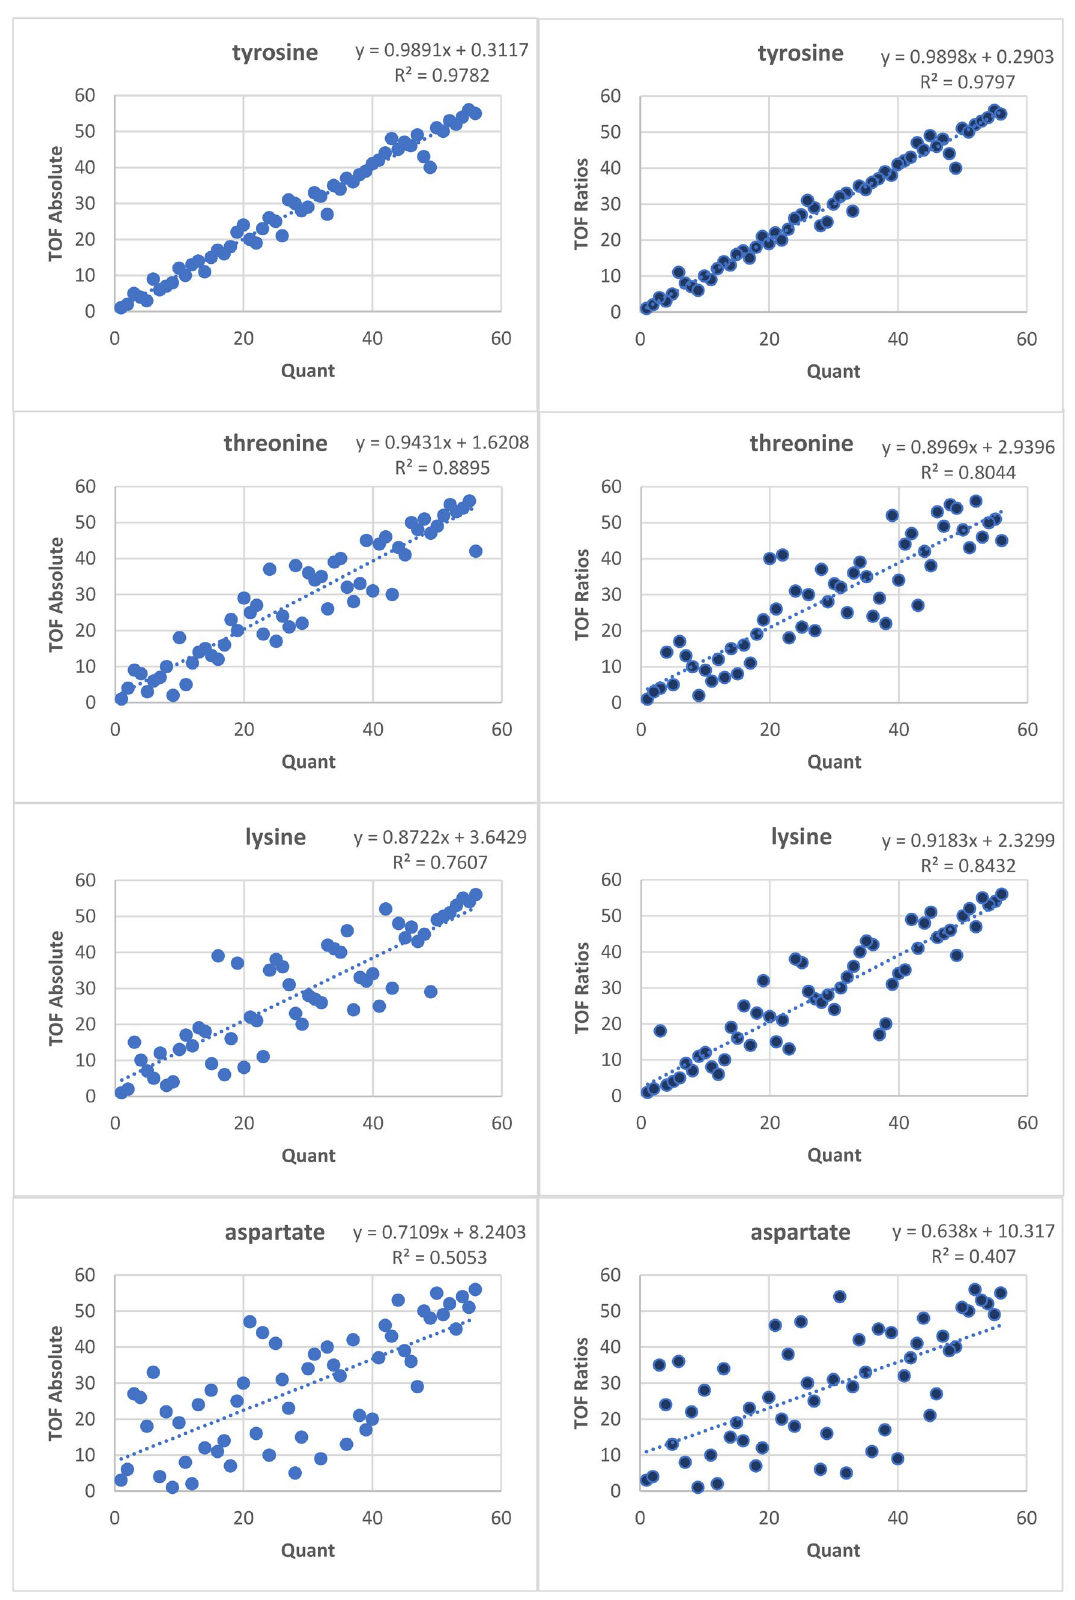
Figure 2. From the assigned TOF absolute ranks (in blue), the theoretical ranks (i.e., the points on the regression line shown in purple) are subtracted, yielding the row “Difference”, which indicates the individual deviations from the regression line.